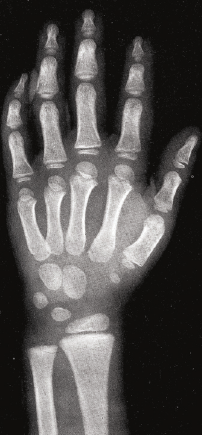
Figure 1: Hand X-ray used in skeletal age